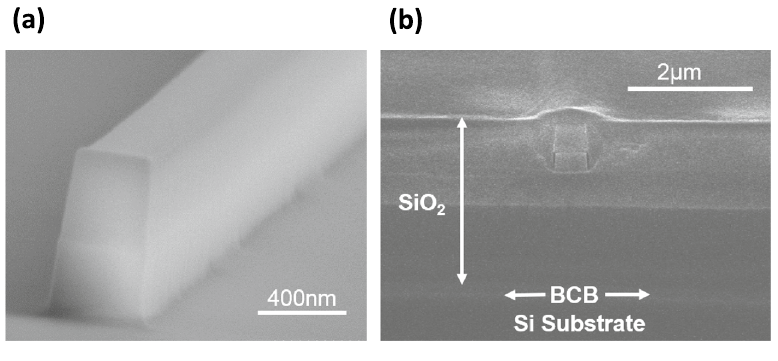
Figure 2. AlGaAs-OI waveguides. ( a ) Scanning electron microscope (SEM) image of an etched AlGaAs-OI waveguide showing minimal sidewall roughness. ( b ) SEM image showing the cross section of the final AlGaAs-OI